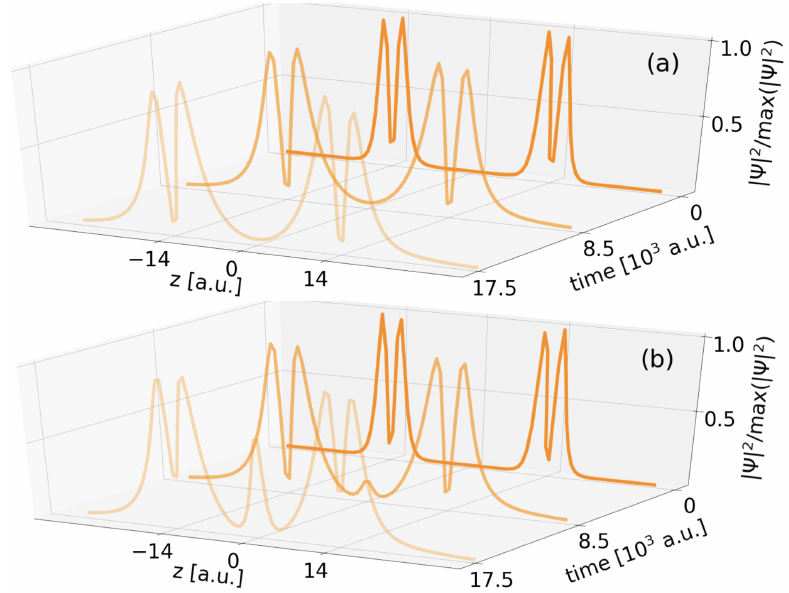
Figure 8. Comparison of the normalized electron density distribution of exICD of a two-electron A ∗ A ∗ state in two ( a ) and three QDs ( b ) for three propagation time-steps and R AA =